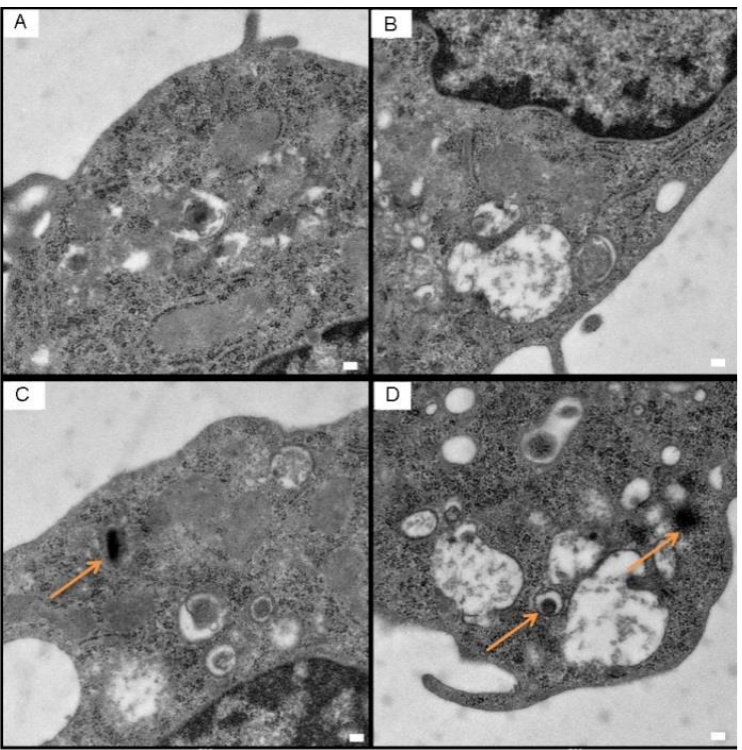
Figure 3. TEM images of Raw264.7 cells incubated with or without CuCo 2 S 4 NCs/CL. ( A , B ) Normal macrophages without CuCo 2 S 4 NCs/CL. ( C , D ) Macrophages incubated with CuCo 2 S 4 NCs/CL. The phagocyted CuCo 2 S 4 NCs/CL is marked with arrows. All scale bars = 500 nm.